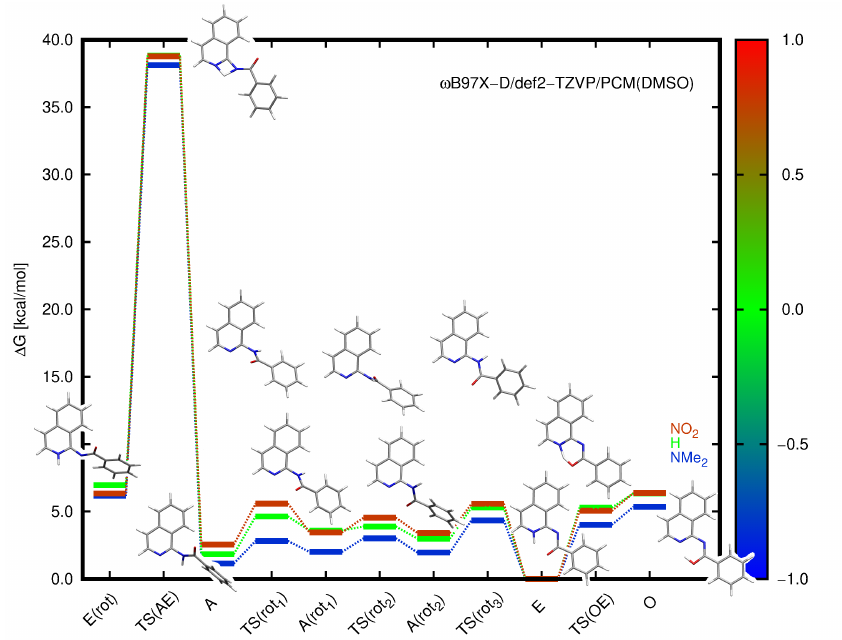
Figure 3. Relative Gibbs free energies (kcal/mol) for the NMe 2 , H, and NO 2 -substituted derivatives ( 1 , 5 , and 10 ) calculated within the ω B97X-D/def2-TZVP approach for the implicit solvent model. The color scale corresponds to the Hammett constant value of the substituent, and the presented structures are given for the unsubstituted system 5 . TS( AE ) and TS( OE ) denote the transition state structures for the proton transfer between the corresponding tautomers, and the remaining TS labels apply to the rotation of the amide along the single C-N bond. E (rot) and A (rot n ) stand for the optimized rotamers of the corresponding